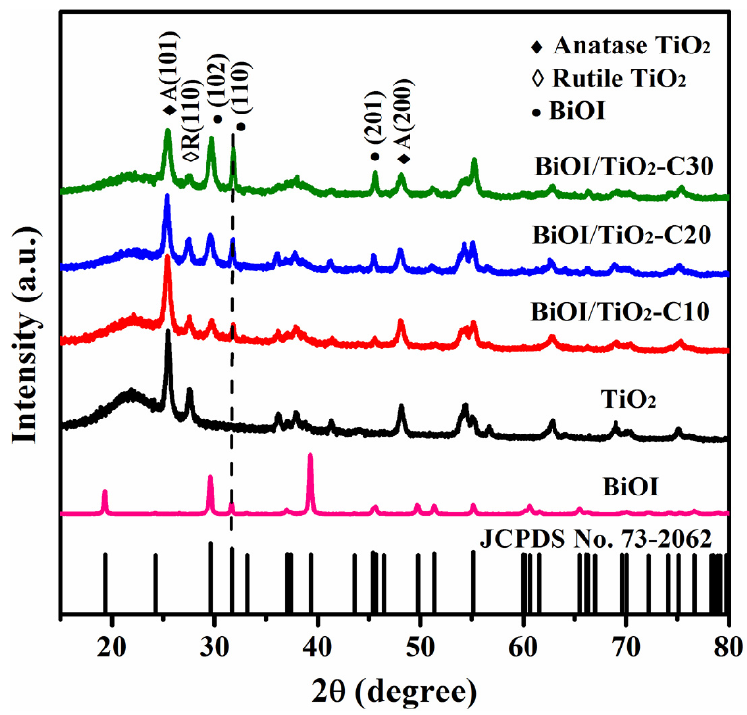
Figure 3. XRD patterns of different samples.